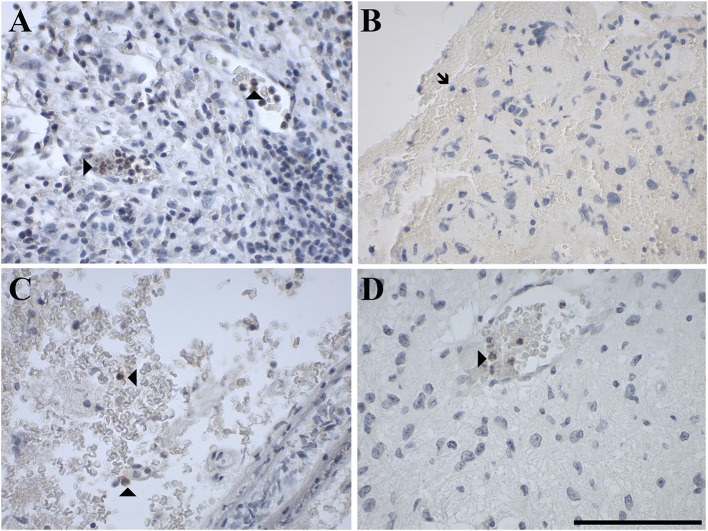
Representative images of immunohistochemical staining of neutrophil granulocytes stained positive for (A) GAL in a gliosarcoma (WHO grade IV; case 29), negative for (B) GAL1-R in a gliosarcoma (WHO grade IV; case 29) and positive for (C) GAL2-R in an anaplastic astrocytoma (WHO grade III; case 15) and (D) GAL3-R in a pilocytic astrocytoma (WHO grade I; case 5). Arrow heads indicate positive-stained neutrophil granulocytes, the arrow indicates a negative neutrophil granulocyte. [scale bar: 100 μm].